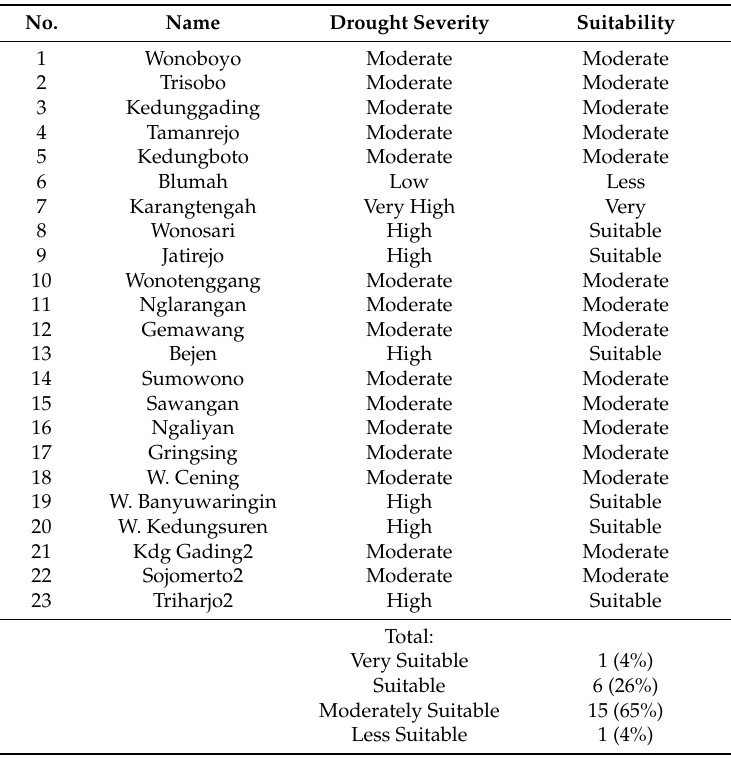
Table 7. Location suitability of the small reservoirs under